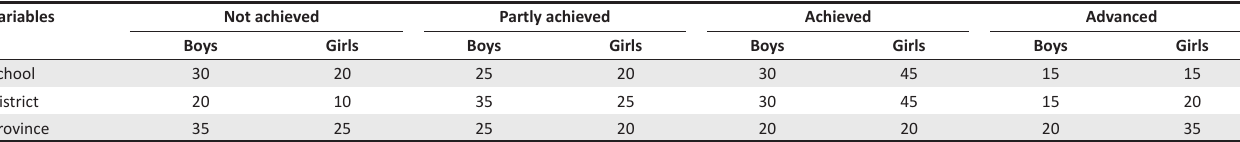
TABLE 4-A1: Mean score ( % ) by district, province and gender.